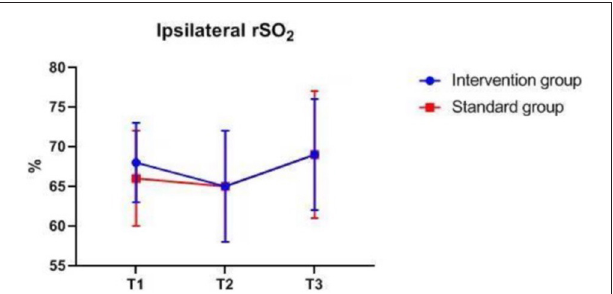
FIGURE 2 | MAP over time. MAP, mean arterial blood pressure. The measurement time interval after general anesthesia but before clamping the carotid artery was recorded as baseline reference T1, the time interval after clamping but before declamping was recorded as T2, and the time interval after the declamping and stabilization of cerebral perfusion but before completion of surgery was recorded as T3.